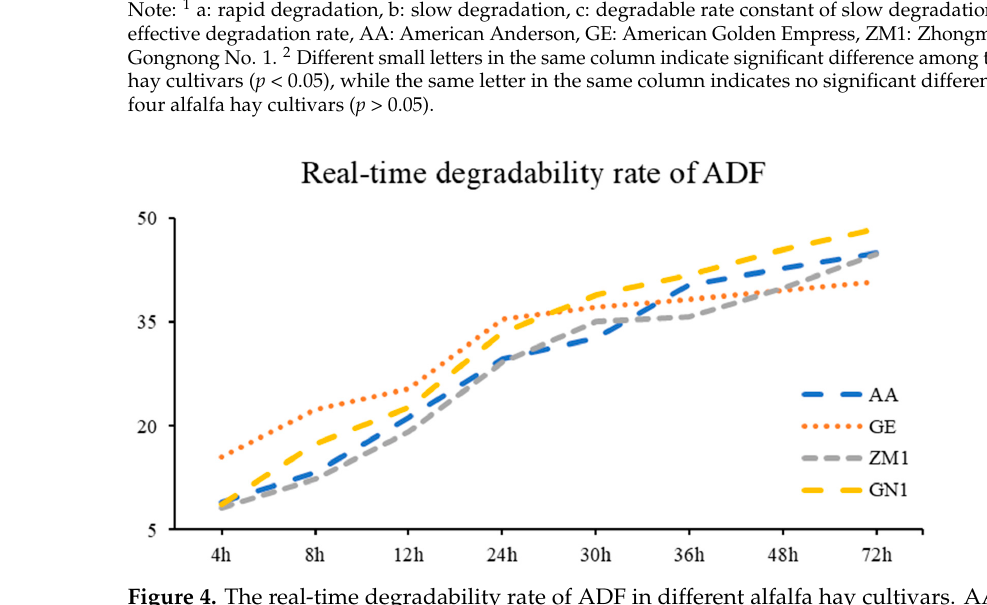
Table 8. Evaluation of feed value from various alfalfa hay cultivars %.